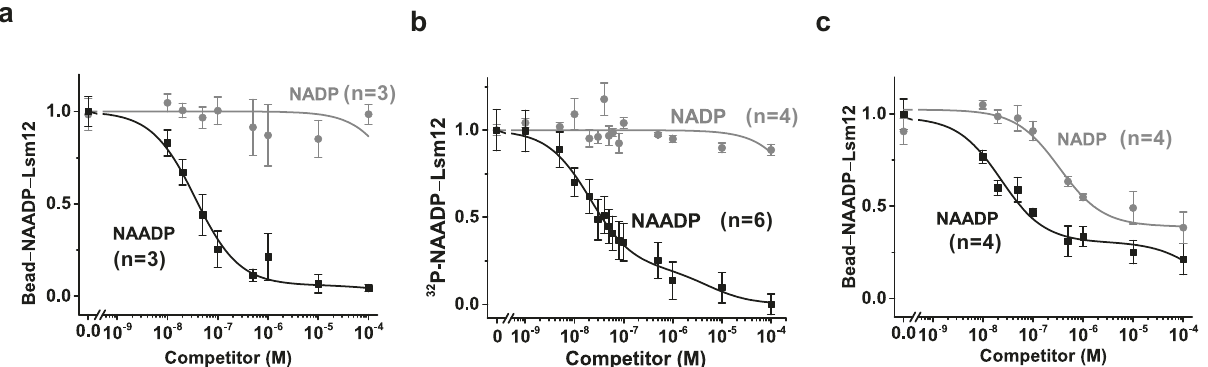
Fig. 3 Lsm12 functions as a high-af fi nity NAADP receptor. a Plot of the relationship between hLsm12-His E.coli pulled down by immobilized NAADP and the concentrations of free NAADP and NADP. b Competition radioligand binding assay of the association between 32 P-NAADP and puri fi ed hLsm12-His E.coli in the absence or presence of various concentrations of non-radiolabeled NAADP and NADP. c Plot of the relationship between HEK293 endogenous Lsm12 pulled down by immobilized NAADP and the concentrations of free NAADP and NADP. Data were presented as mean value ± SEM.